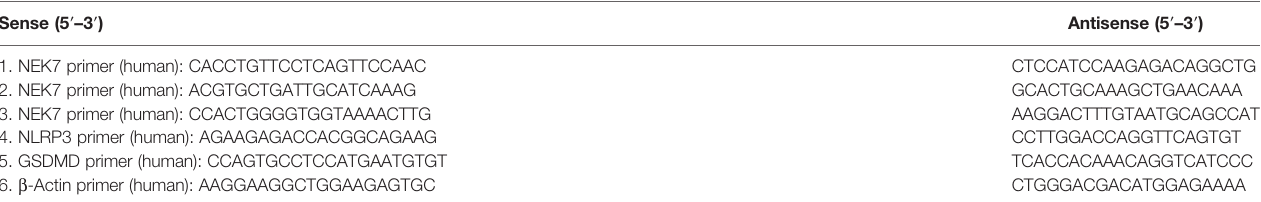
TABLE 2 | The clinicopathological characteristics of HCC patients. Sense (5 ′ – 3 ′